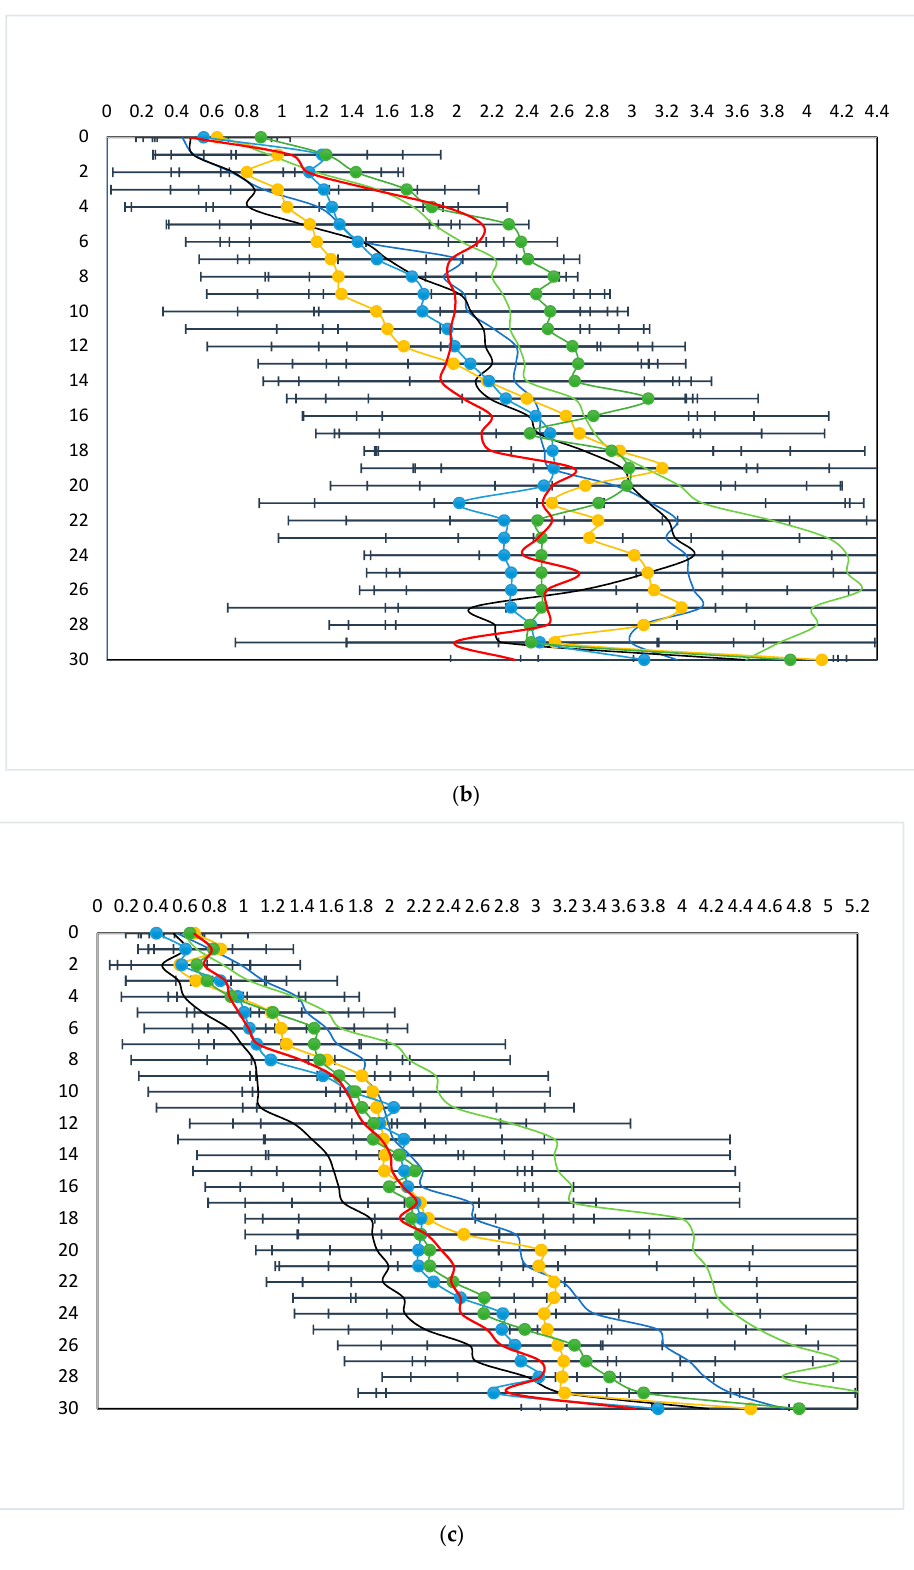
Figure 4. Impact of multi-cropping on soil penetration resistance, 2021. ( a ) Beginning of the vegetative season; ( b ) middle of the vegetative season; and ( c ) end of the vegetative season. MA: maize, HE: hemp, and FB: faba bean mono-crops. MA + HE: maize + hemp, MA + FB: maize + faba bean, and HE + FB: hemp + faba bean binary-crops. MA + HE + FB: maize + hemp + faba bean ternary-crop. Bars mean standard deviation.